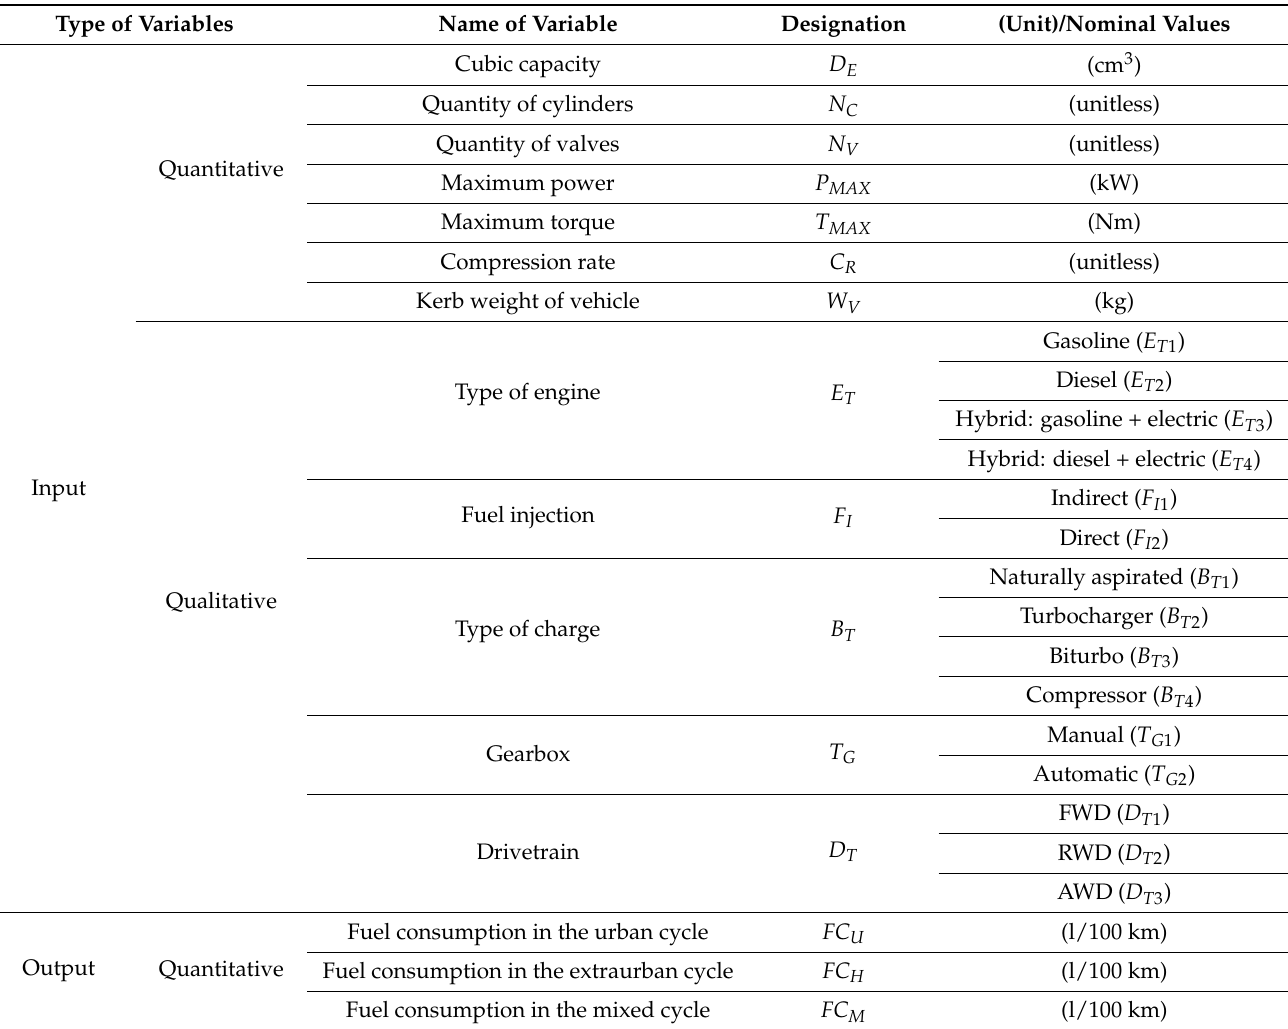
Table 2. List of the input and output